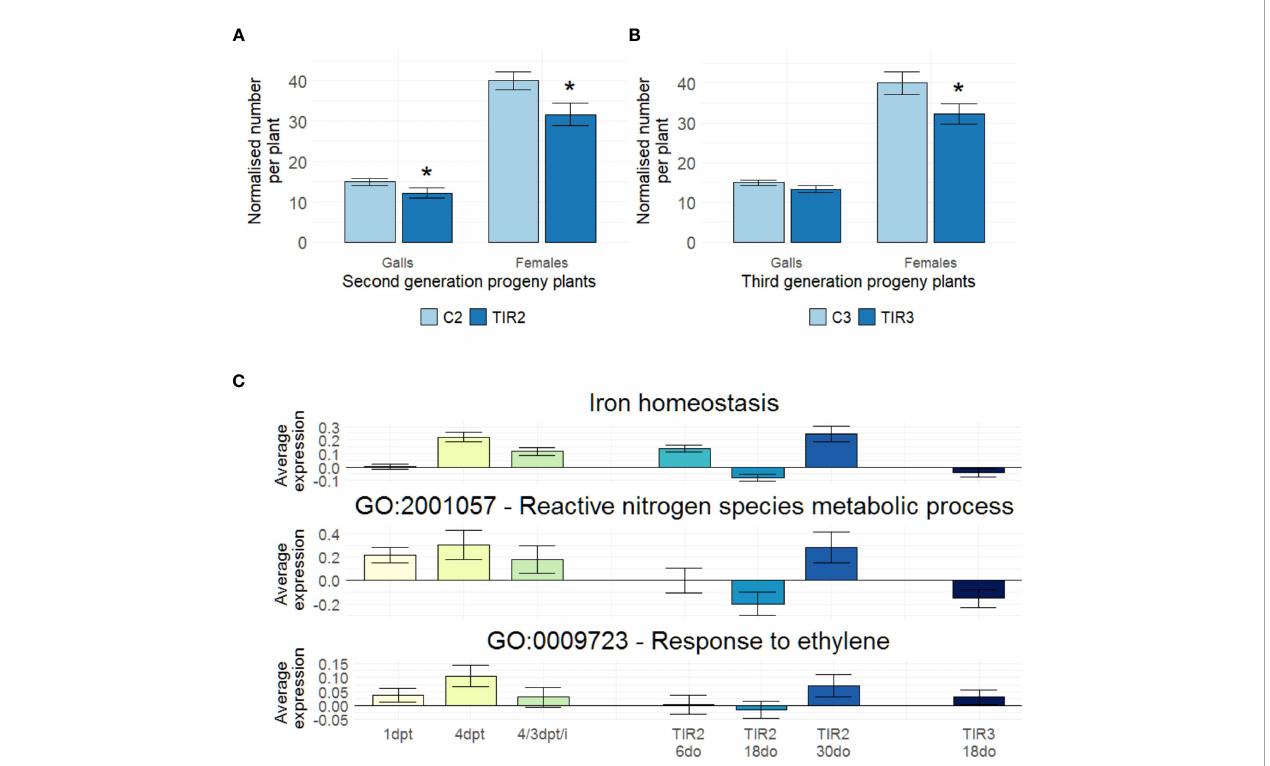
FIGURE 4 Diproline-induced resistance is inherited transgenerationally, with similar pathways affected in ancestor and progeny plants. (A, B) Normalized number of galls and number offemales, as assessed fourteen days post inoculation with 250 Meloidogyne graminicola ( Mg ) second-stage juvenile nematodes for untreated (A) second and (B) third generation progeny plants. (n = 24). (C) Average relative expression values as determined via RNA seq in all studied samples for the Fe homeostasis-related genes illustrated in Figure 1 (73 genes), the genes annotated with the GO term ‘ reactive nitrogen species (RNS) metabolic process ’ (GO:2001057; 7 genes) and the genes annotated with the GO term ‘ response to ethylene (ET) ’ (GO:0009723; 36 genes). ‘ C2 ’ and ‘ TIR2 ’ : progeny of ancestor plants that were lifelong biweekly treated with water or 500 µM diproline, respectively. ‘ C3 ’ and ‘ TIR3 ’ : progeny of untreated C2 and TIR2 plants, respectively. (A, B) Asterisks indicate signi fi cant differences upon comparison of TIR2 and TIR3 plants with C2 and C3 plants, respectively, using a two-sided heteroscedastic t-test (p < 0.05). Error bars represent the standard error of the mean. (C) Expression levels are quanti fi ed as log2fold changes, using same-aged, untreated C2 and C3 plants as controls. Only for the ‘ 4/3 dpt/i ’ data, Mg-inoculated plants at 3 dpi were used as